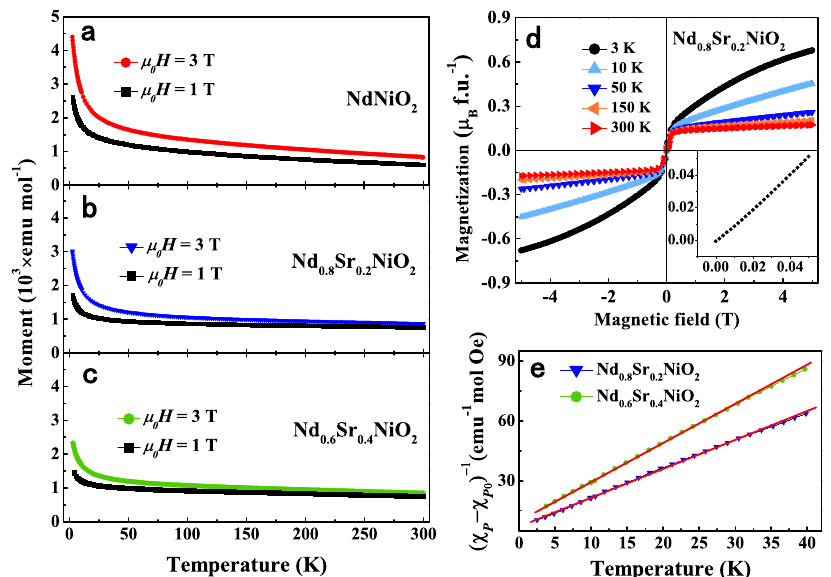
Fig. 3 Magnetic properties of Nd 1 − x Sr x NiO 2 ( x = 0, 0.2, 0.4) samples. a – c Temperature dependence of magnetic moment measured at the fi elds of 1 and 3 T for NdNiO 2 , Nd 0.8 Sr 0.2 NiO 2 and Nd 0.6 Sr 0.4 NiO 2 samples. d Magnetization hysteresis loops for Nd 0.8 Sr 0.2 NiO 2 sample at different temperatures. Inset shows a linear relation between M with H at low fi eld. e Temperature dependence of χ P (cid:2) χ P (cid:1) (cid:3) (cid:2) 1 versus T linear relation of χ P (cid:2) χ P 0